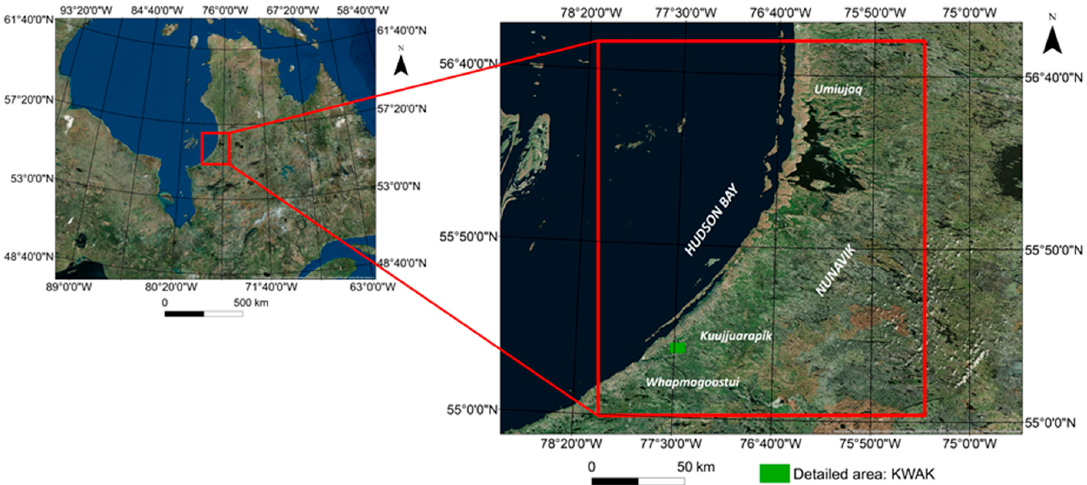
Figure 1. Location of the Kwakwatanikapistikw River (KWAK) study area (Source: Esri, DigitalGlobe, GeoEye, Earthstar Geographics, CNES/Airbus DS, USDA, USGS, AeroGRID, IGN, and the GIS User Community).